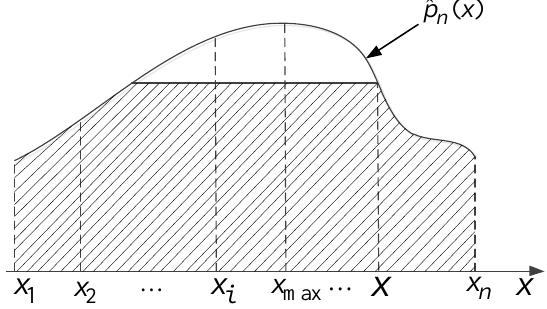
Figure 4. The estimation of overall probability density function (x)